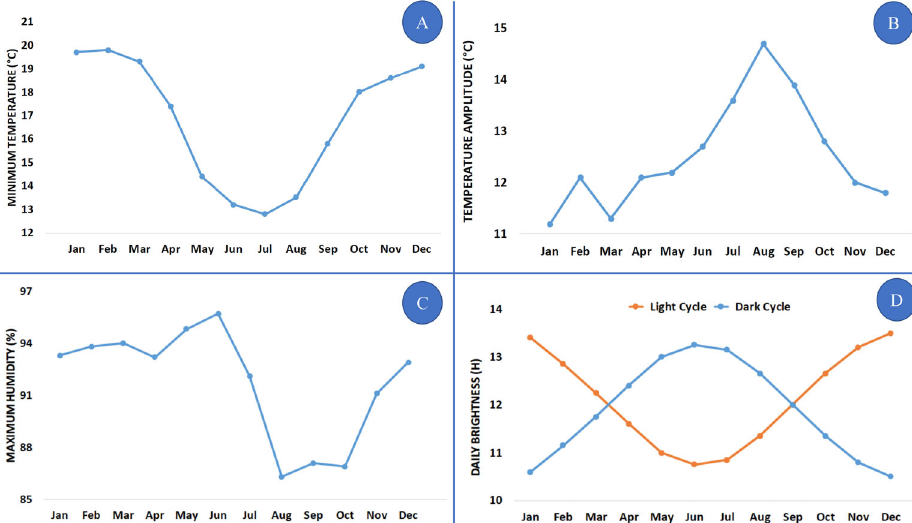
Figure 2. Time series analysis for minimum temperature ( A ), temperature amplitude ( B ), maximum humidity ( C ), and dark/light cycles ( D ) during the eight-year study period. The ARIMA model was used, and the following information was achieved: A , R 2 =0.779; spatio- temporal stationary R 2 =0.551; RMSE (root mean square error) =1.418; BIC (Bayesian information criterion) =0.805. B , R 2 =0.459; spatio- temporal stationary R 2 =0.236; RMSE=1.925; BIC=0.907. C , R 2 =0.827; spatio-temporal stationary R 2 =0.568; RMSE=1.339; BIC=0.775. D , (light cycle) R 2 =0.559; spatio-temporal stationary R 2 =0.331; RMSE=1.556; BIC=0.857; (dark cycle) R 2 =0.441; spatio-temporal stationary R 2 =0.356; RMSE=1.026;